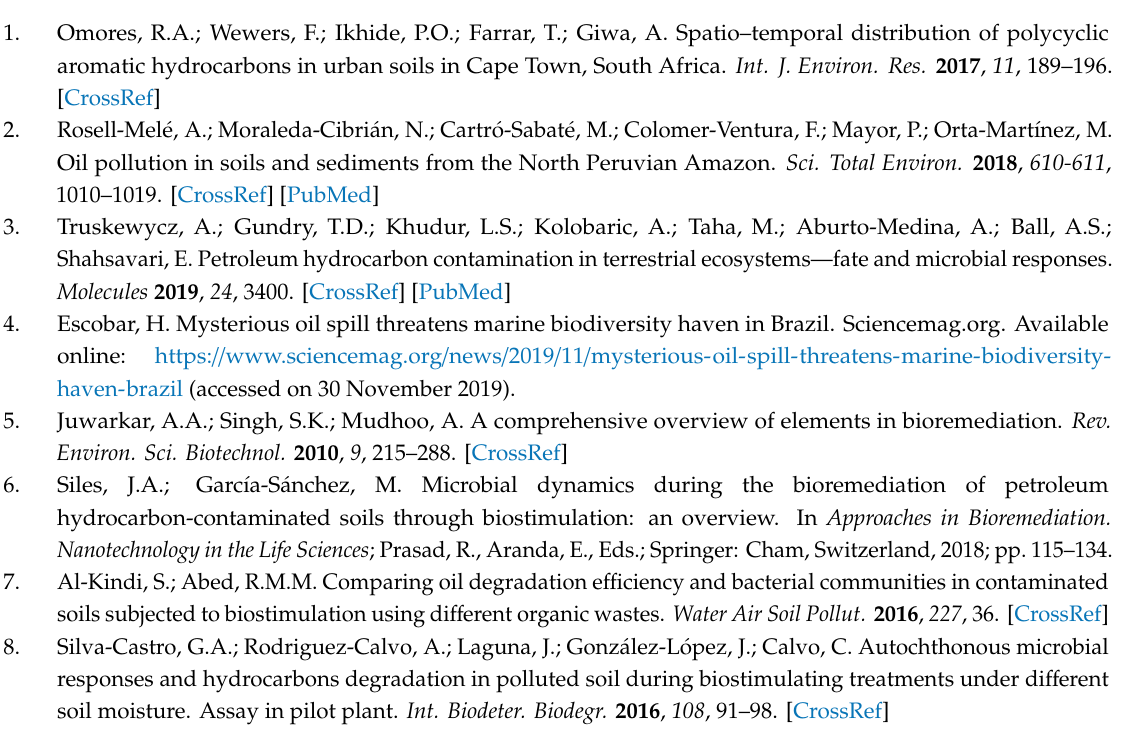
Supplementary Materials: The following are available online, Supplemental Experimental Procedures, Figure S1: The results of MEGAN analysis demonstrating taxonomic assignment of BLAST hits of the reads associated with alkane monooxygenase, to the NCBI nr database. Table S1: Information regarding sequence quality control of the analyzed metatranscriptomic